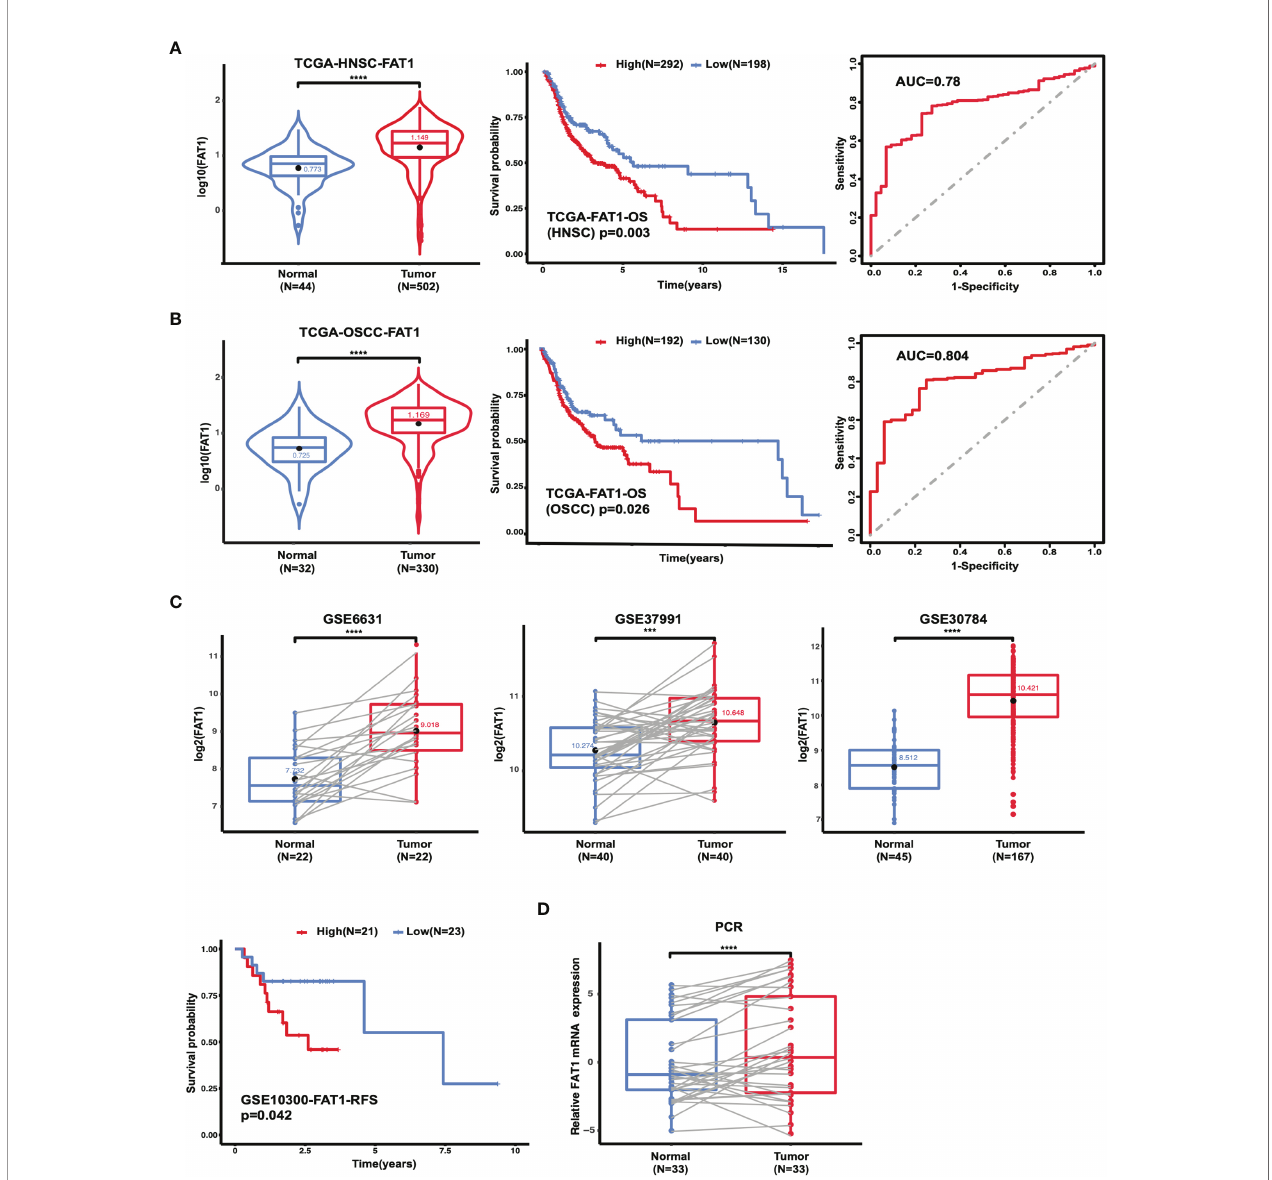
FIGURE 1 | The FAT1 mRNA level is upregulated in HNSC and OSCC, and a higher FAT1 expression level is associated with shorter overall survival. (A) FAT1 mRNA expression status between normal tissues and tumor tissues in HNSC from TCGA (boxplot and violin plot); Kaplan – Meier survival curve of overall survival time in HNSC from TCGA; areas under the curve (AUCs) of the ability to discriminate normal tissues and tumor tissues by the FAT1 mRNA level in HNSC from TCGA. (B) FAT1 mRNA expression status between normal tissues and tumor tissues in OSCC from TCGA (boxplot and violin plot); Kaplan – Meier survival curve of overall survival time in OSCC from TCGA; areas under the curve (AUCs) of the ability to discriminate normal tissues and tumor tissues by FAT1 mRNA level in OSCC from TCGA. OSCC is the main subtype of HNSC (including the sites of mouth, cheek mucosa, tongue, hard plate, lip, and gum). (C) FAT1 mRNA expression status in paired tumor and non- tumor pair-wise data sources (GSE6631 and GSE37991) and another GSE30784 set (boxplot). Kaplan – Meier survival curve of recurrence-free survival time in HNSC from GSE10300. (D) FAT1 mRNA expression status in clinical samples (boxplot). ***P < 0.001; ****P <